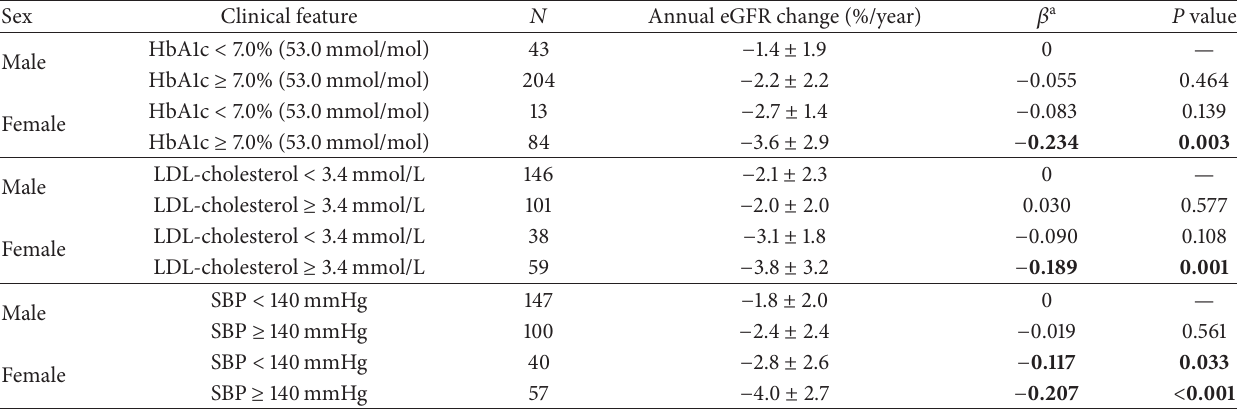
a Adjusted for baseline age. Table 3: The effects of the combination of sex and metabolic status-abnormalities on the annual eGFR